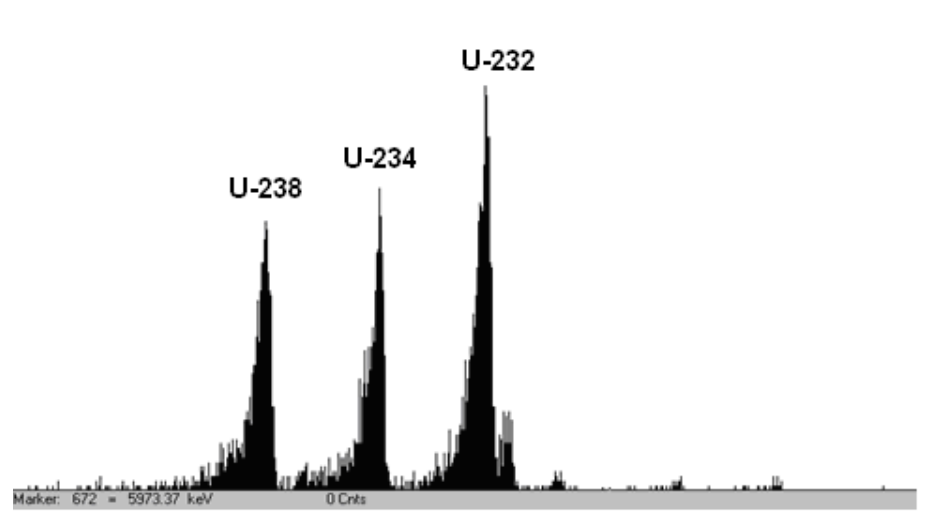
FIGURE 1 . Alpha spectrum of Th fraction after separation soil sample.